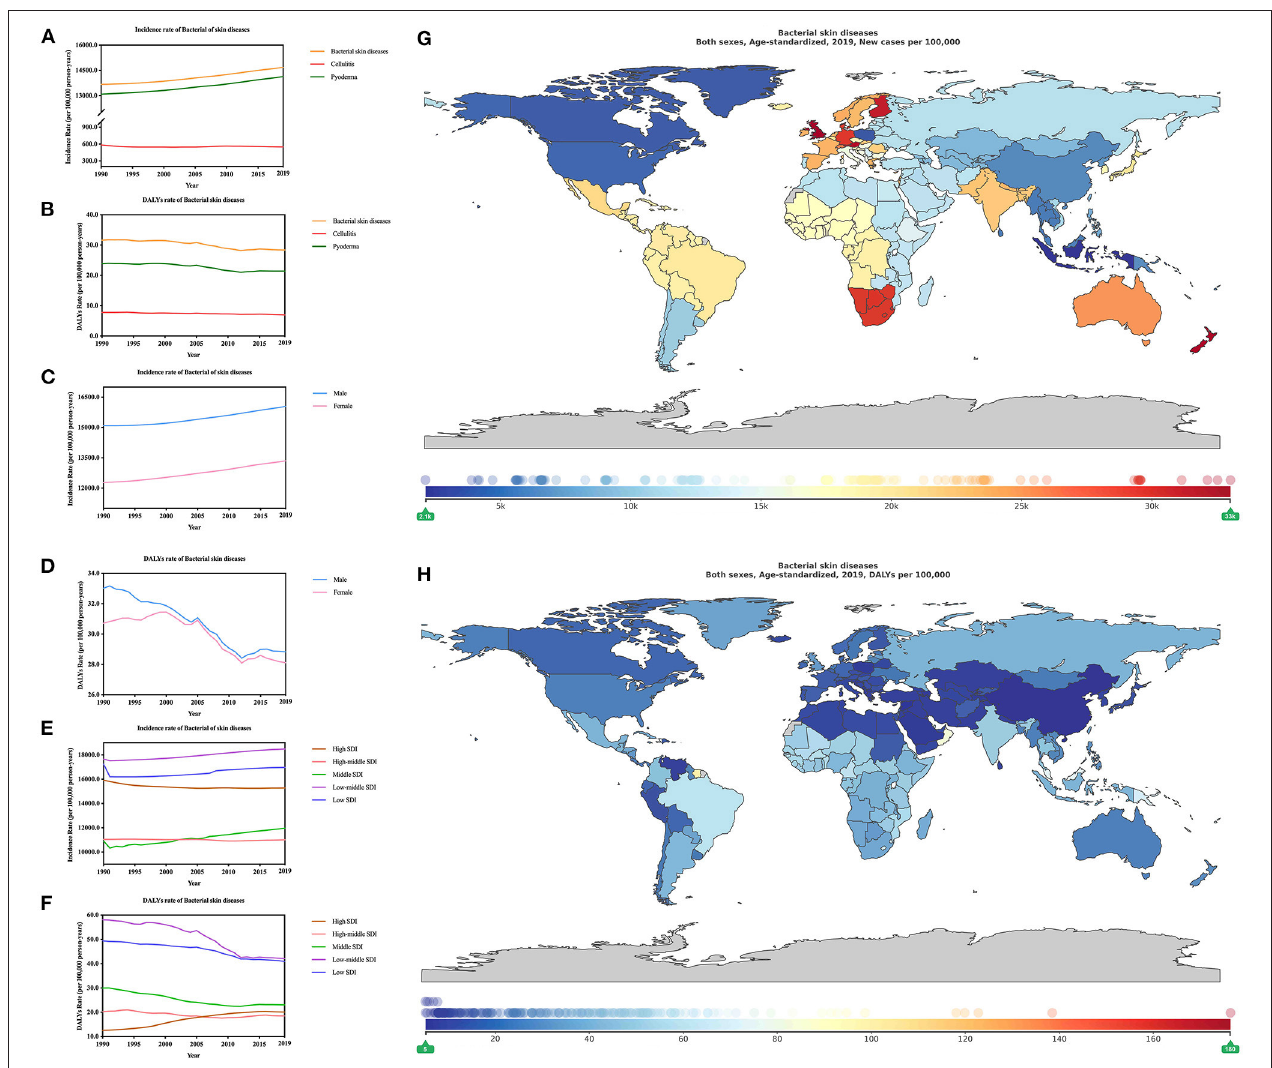
FIGURE 1 | Burden of major bacterial skin diseases for 204 countries and territories. Age-standardized incidence and DALYs rates of major bacterial skin diseases (A,B) by type; (C,D) by sex; (E,F) by SDI per 100,000 people globally, 1990–2019. The distribution of age-standardized incidence (G) and DALYs (H) rates of bacterial skin diseases per 100,000 population globally, in 2019.